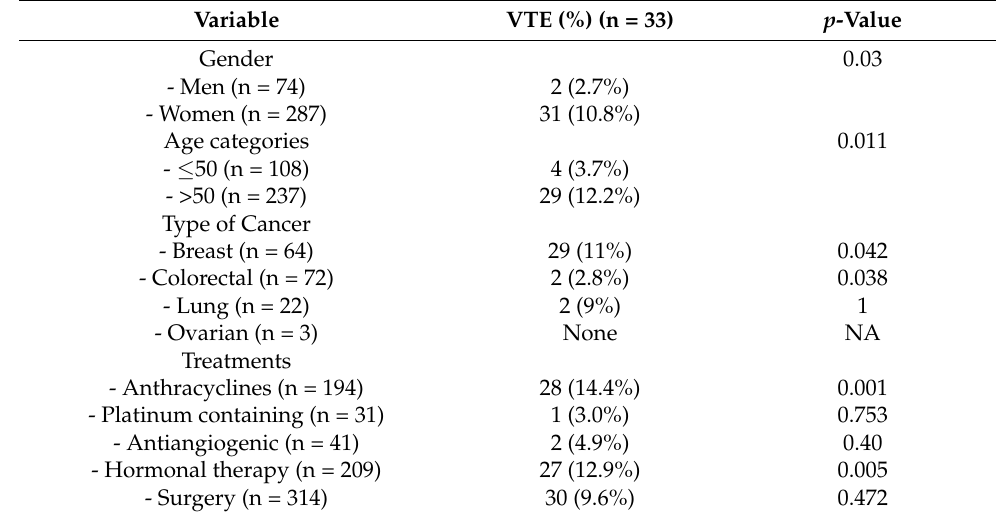
Table 3. Fischer exact test for VTE in the radiotherapy cohort across different categories